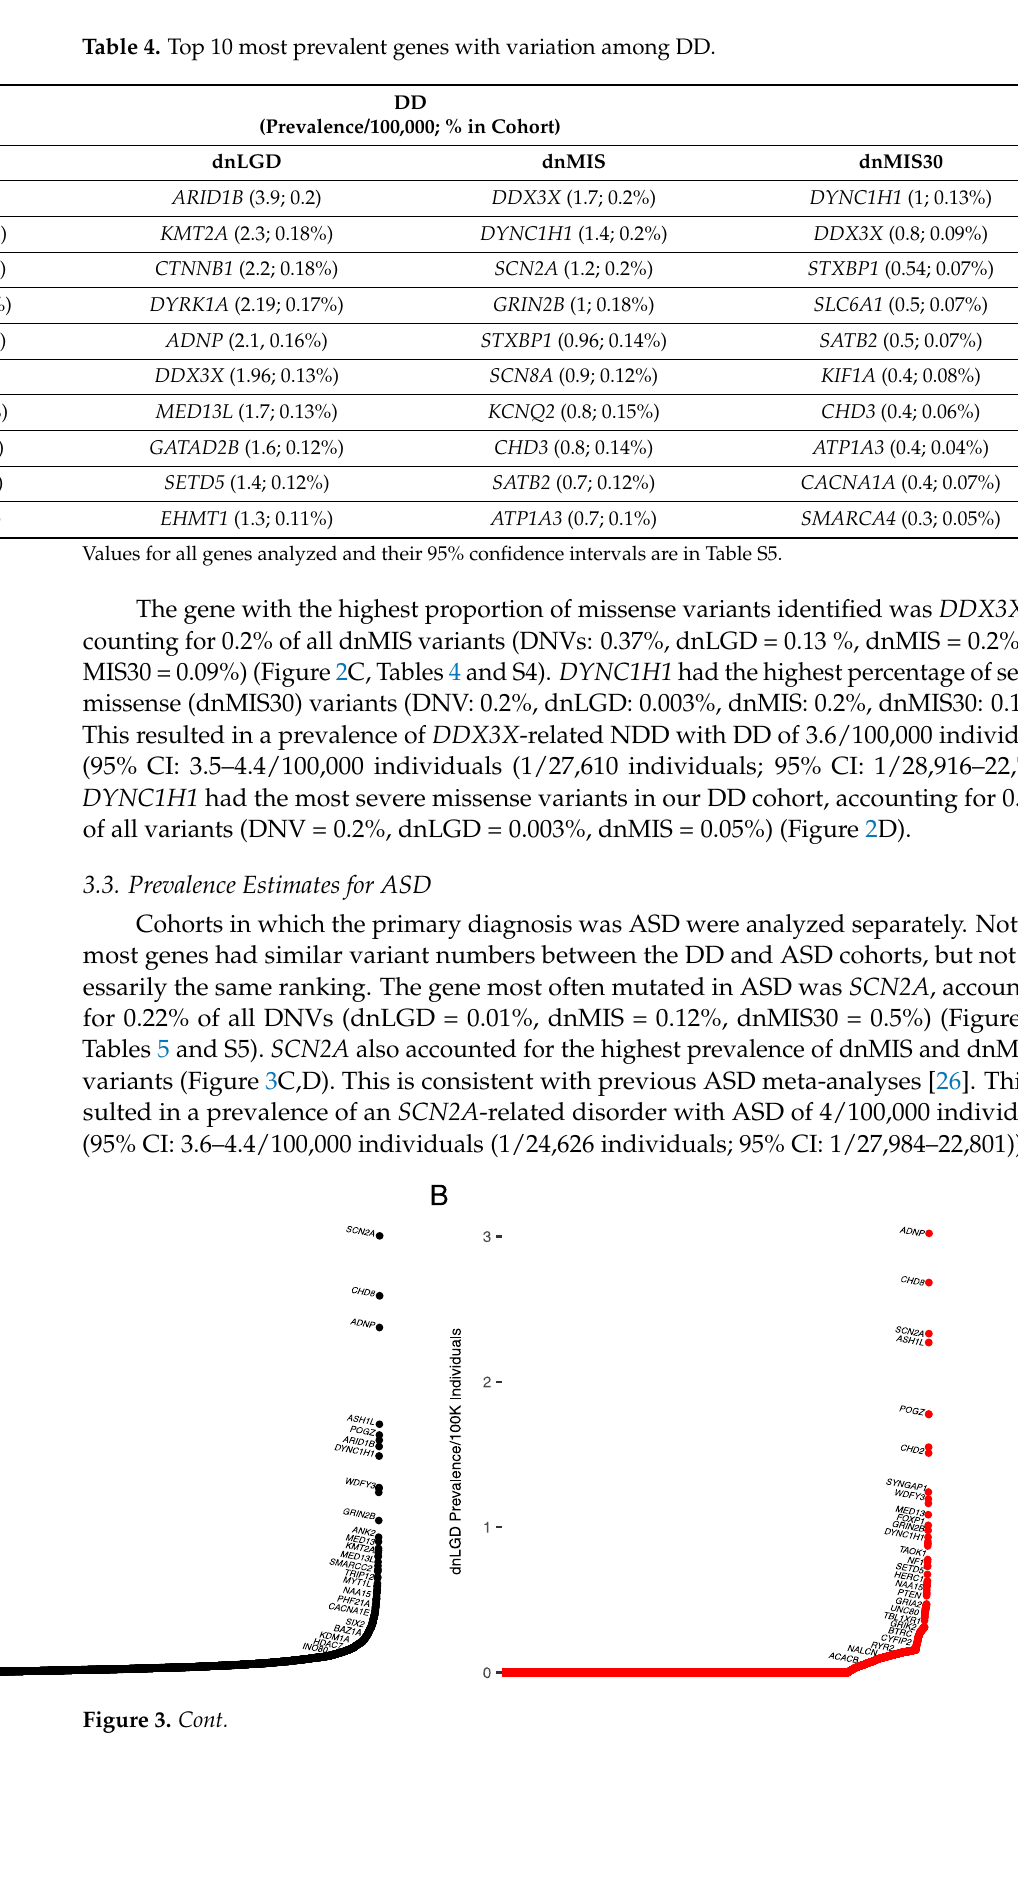
Figure 3. Prevalence of DNVs by gene extrapolated from number of cases in ASD cohort. Genes are indicated along the x -axis, with prevalence of each variant type on the y -axis. ( A ) ASD DNV cases, ( B ) ASD dnLGD cases, ( C ) ASD dnMIS cases, and ( D ) ASD dnMIS30 cases. The proportion of each gene and mutation type in our cohort was multiplied by the estimated prevalence of ASD from Zablotsky and Black, 2020.